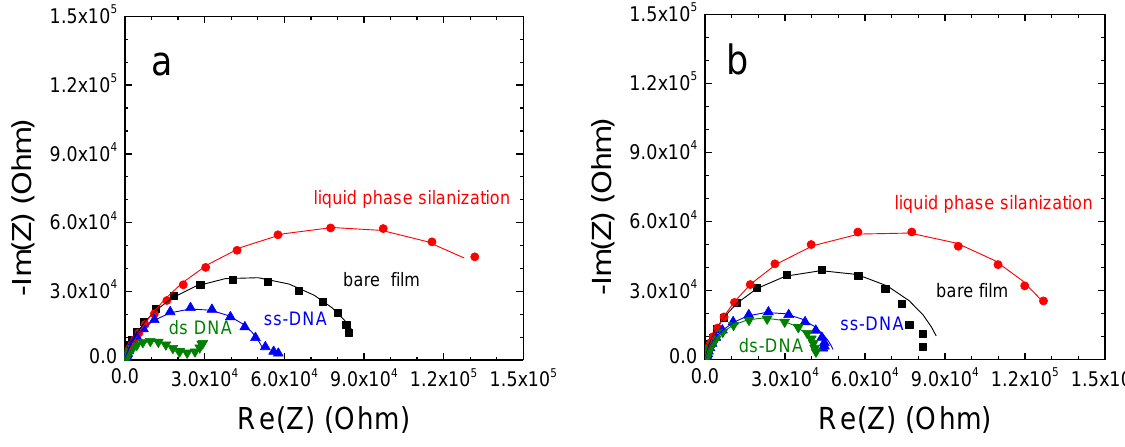
Figure 4. Nyquist plots of bio-modified 220 ± 20 nm thick SnO 2 nanoporous films. DNA hybridization was performed with ( a ) complementary and ( b ) non-complementary DNA targets with target concentration of 2 µM. The filled symbols correspond to experimental data and the continuous lines to fitting data.